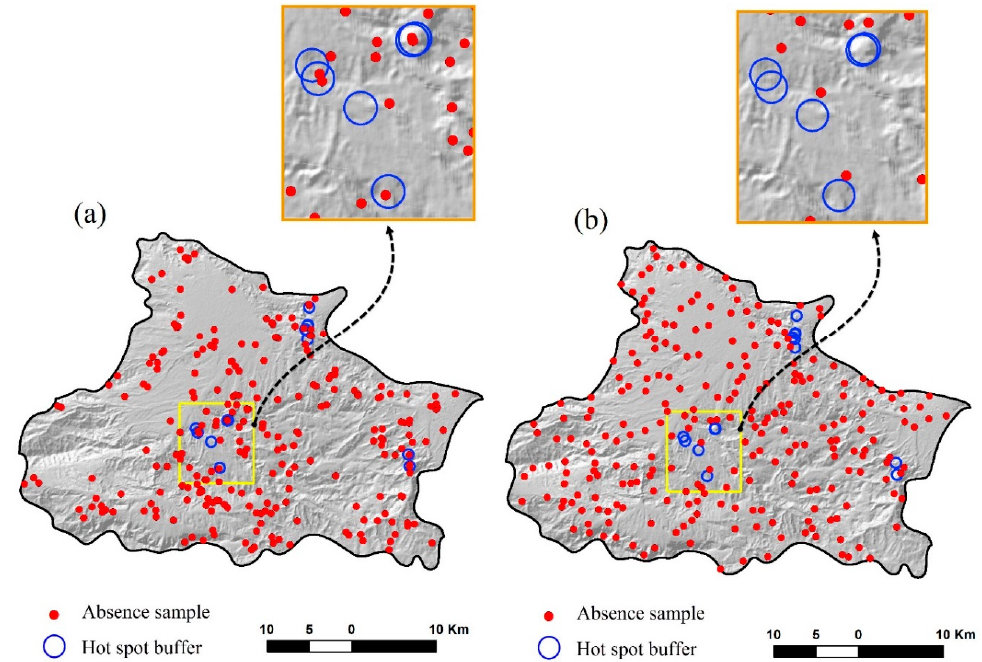
Figure 6. Maps of absence samples produced using ( a ) a random sampling method, and ( b ) the selection of absence samples (SAS) method. of absence samples (SAS)